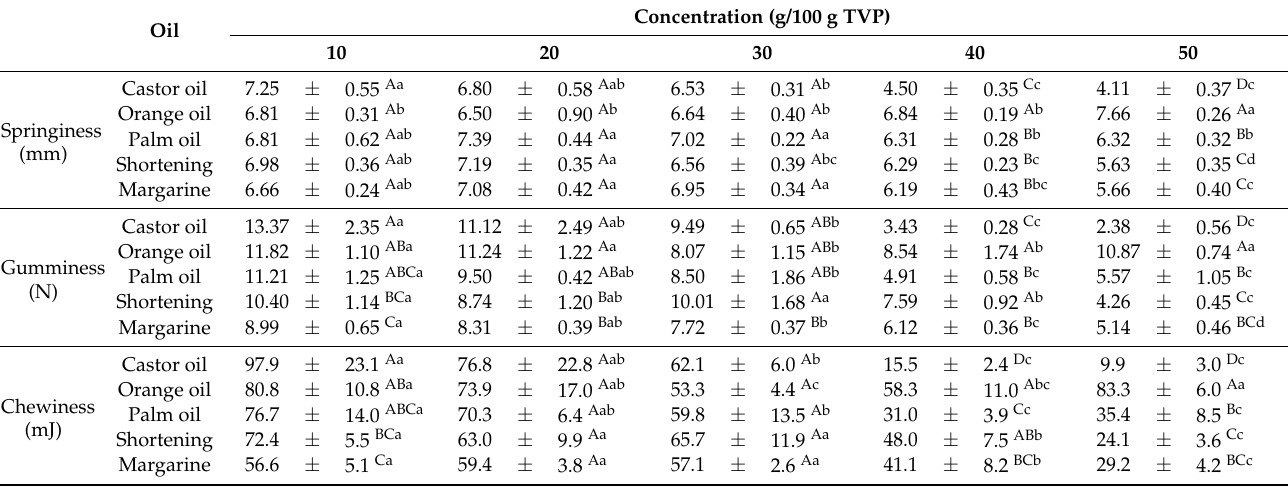
Table 8. Texture profile analysis (springiness, gumminess, and chewiness) of meat analog supple- mented with different types or amounts of vegetable oils.